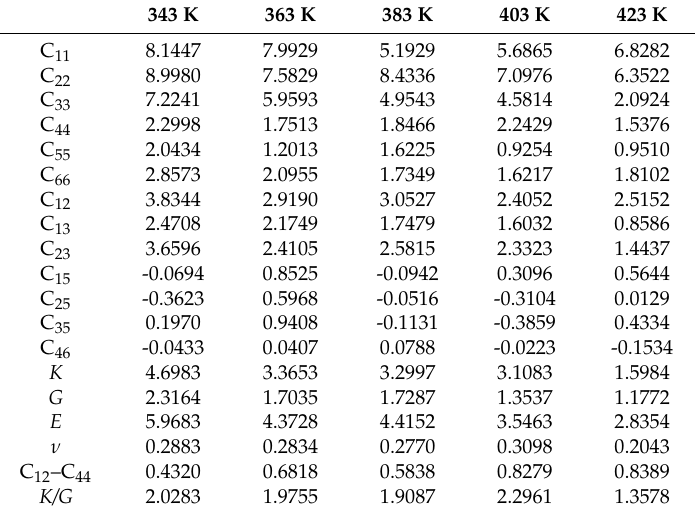
Mechanical parameters (GPa) of the amorphous regions of meta-aramid fibers at different